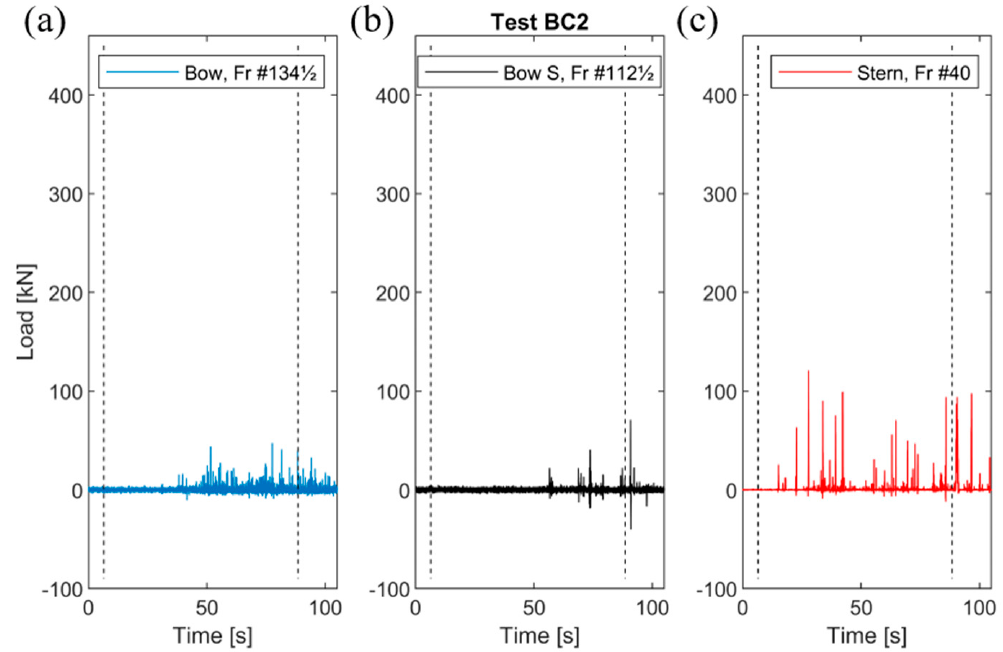
Figure A6. Measured ice-induced loads at ( a ) bow, ( b ) bow shoulder, and ( c ) stern shoulder during test BC2.